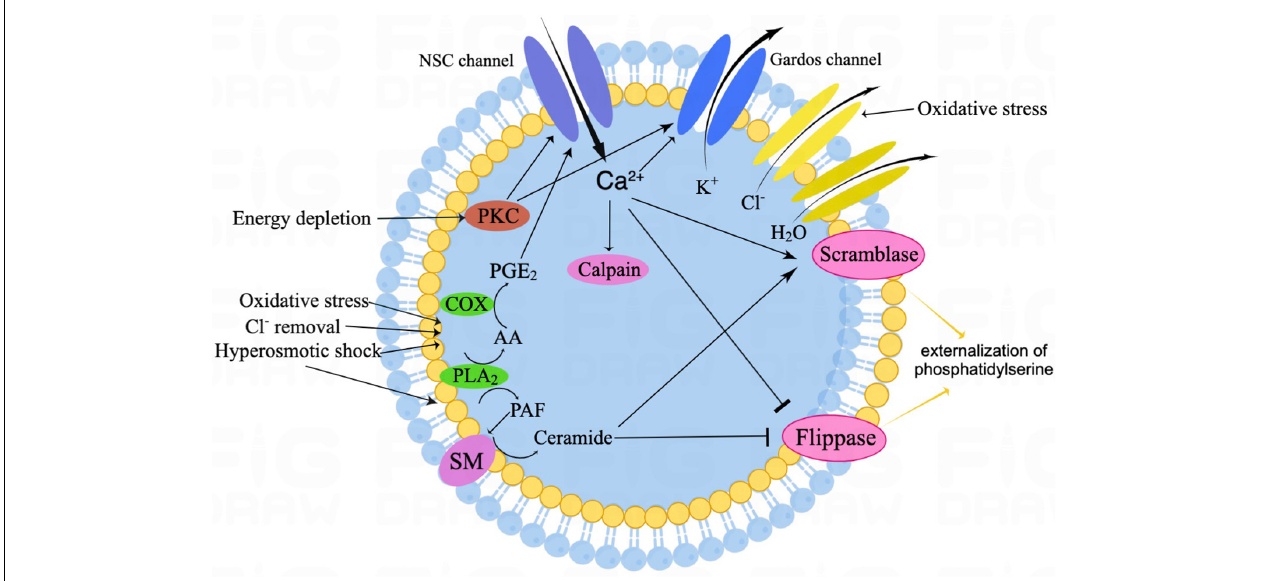
FIGURE 1 | The schematic illustration of canonical eryptosis signaling. Eryptosis is mainly stimulated by increased intracellular Ca 2 + and ceramide. Among oxidative stress, with Cl − removal and hyperosmotic shock, activated PGE 2 stimulates NSC channels, thus resulting in Ca 2 + influx. In addition, hyperosmotic shock also leads to ceramide formation. Then, increased cytosolic Ca 2 + activates Gardos channels, resulting in K + efflux, together with Cl − efflux and osmotically H 2 O outflow, which eventually leads to cell shrinkage. Increased cytosolic Ca 2 + also leads to the translocation of phosphatidylserine (PS) from the inner leaflet of the cell membrane to the erythrocyte surface by activating the scramblase and inhibiting the flippase. In addition, increased cytosolic Ca 2 + further mediates the activation of the calpain, which leads to cell membrane blebbing. Energy depletion triggers eryptosis, mainly by PKC-dependent membrane proteins phosphorylation. NSC, non-selective cation; SM, sphingomyelinase; PKC, protein kinase C; COX, cyclooxygenase; PGE 2 , prostaglandin E2; AA, arachidonic acid; PLA 2 , phospholipase A2; and PAF, platelet-activating